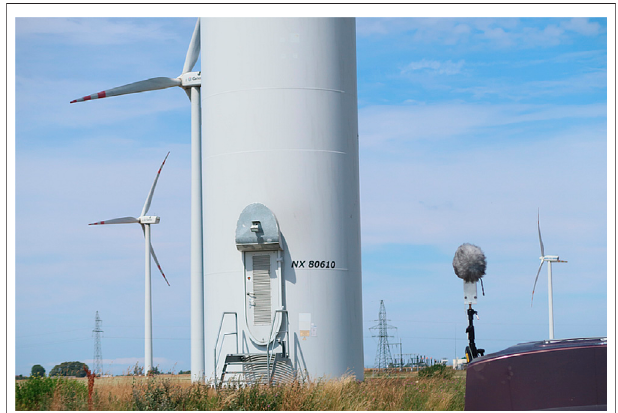
FIGURE 3 | Intensity probe in the windshield during signal